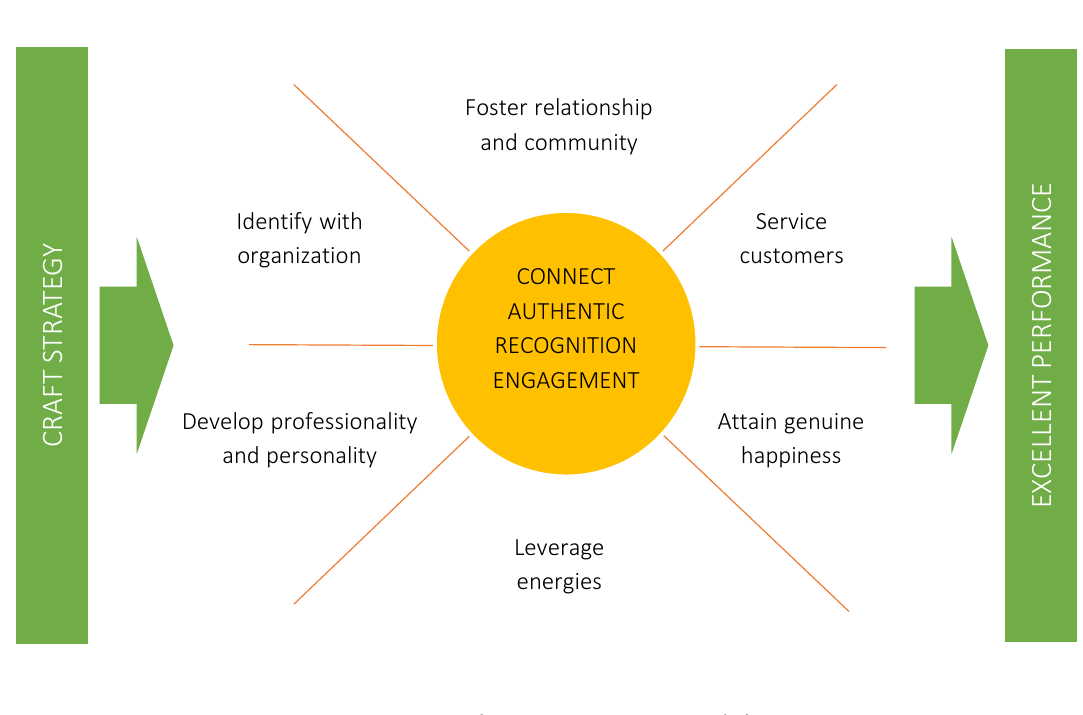
Figure 1. The engagement